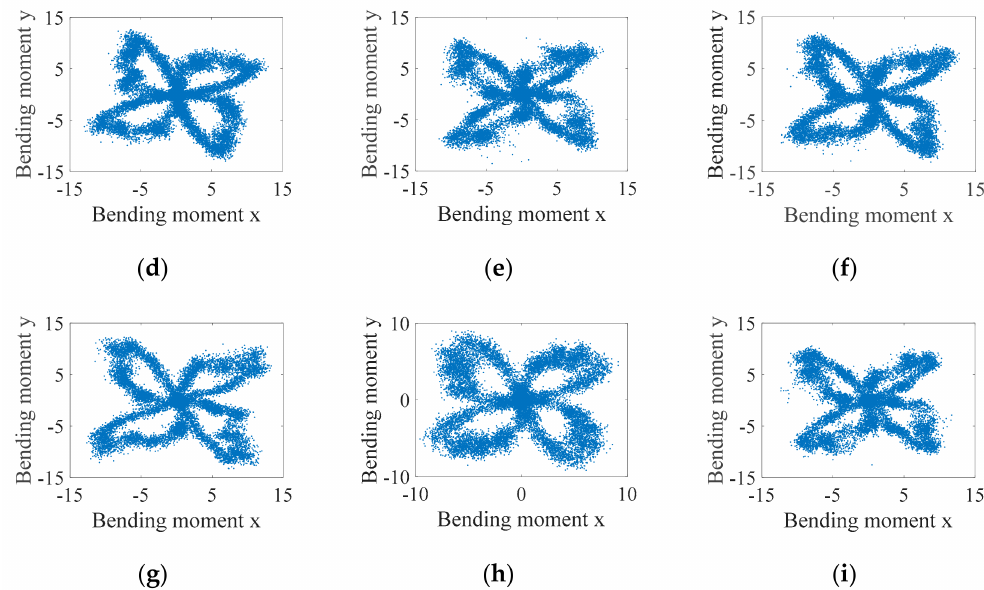
Figure 9. Polar plot of cutting bending moment for stable milling condition. ( a ) No. 1 experiment; ( b ) No. 2 experiment; ( c ) No. 3 experiment; ( d ) No. 4 experiment; ( e ) No. 5 experiment; ( f ) No. 6 experiment; ( g ) No. 7 experiment; ( h ) No. 8 experiment; ( i ) No. 9 experiment.